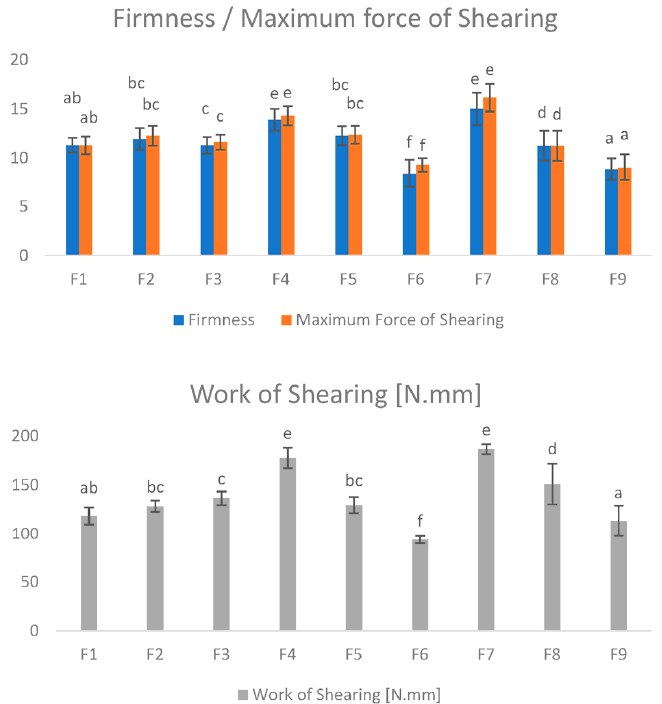
Figure 4. Warner–Bratzler analyses of the 9 hybrid meat samples. The samples, labelled from F1 to F9, contain different percentages of broccoli, upcycled brewer’s spent grain and insect flour (BR, BSG, IF): F1 (35, 0, 0), F2 (30, 5, 0), F3 (25, 0, 1), F4 (20, 5, 10), F5 (30, 0, 5), F6 (32, 3, 0), F7 (25, 5, 5), F8 (22, 3, 10) and F9 (27, 3, 5). Different letters in the same bar are significantly different according to Tukey’s test ( p < 0.05).3.4. Modelling and